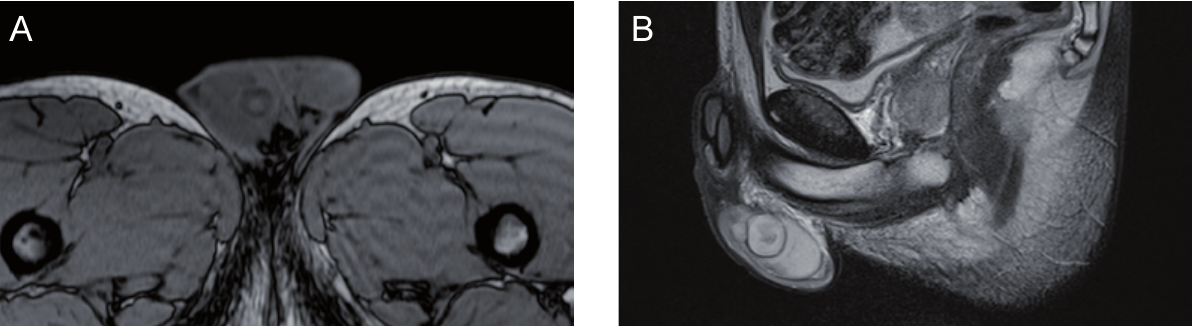
Figure 2 - a. Axial T2-weigthed image confirms the well-circumscribed mass in the upper medial pole of the right testis. The mass has a central slightly hyperintense center and an isointense periphery. b. Sagittal T2-weigthed image confirms the well-circumscribed mass in the upper medial pole of the right testis. The mass had a central slightly hypointense center and a hyperintense periphery.